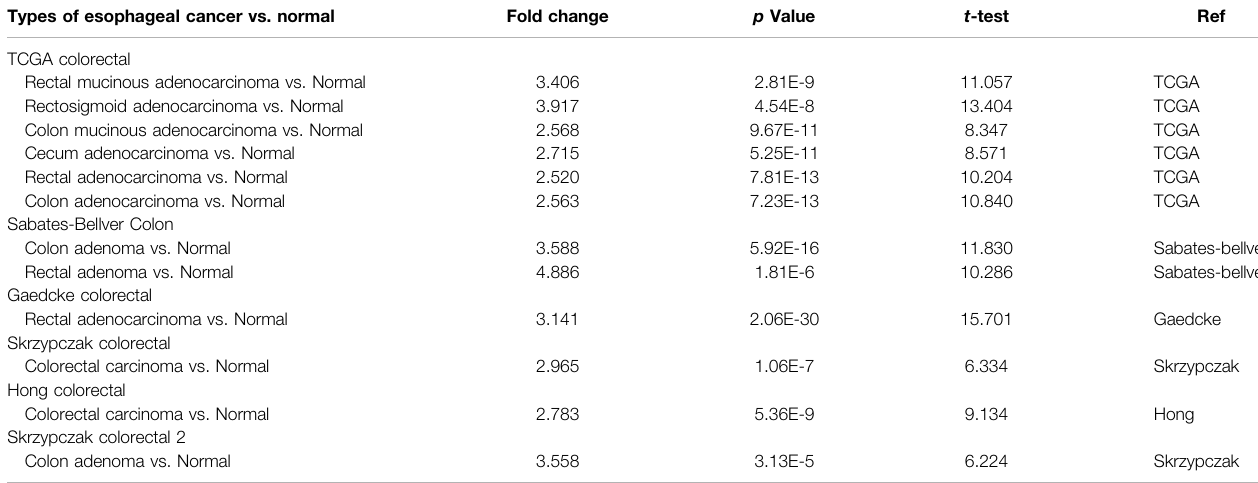
TABLE 1 | The Oncomine database analysis indicated that FATP5 expressions are upregulated in different subtypes of colorectal carcinoma. Types of esophageal cancer vs. normal Fold change p Value